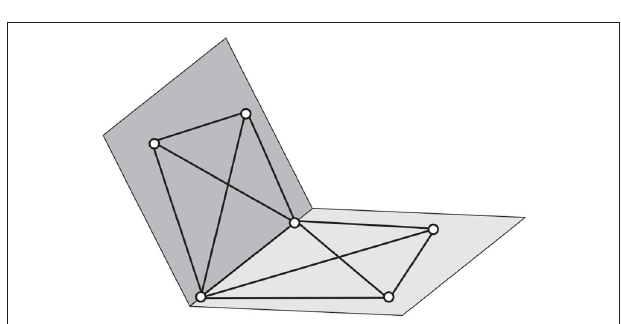
FIGURE 8 | This framework for d = 3 satisfies conditions (1) and (2), but not condition (3) of Theorem 1, there is an affine motion changing the angle between the highlighted planes, preserving all bar